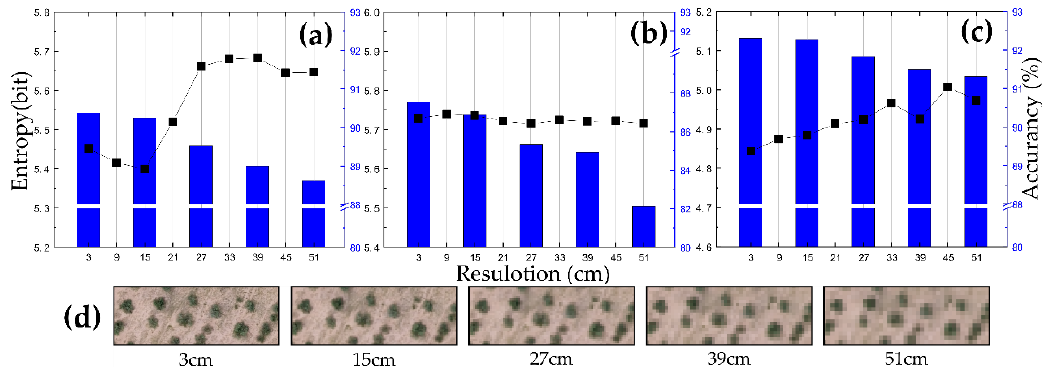
Figure 8. Shrub identification accuracy and information entropy of images at different resolution in